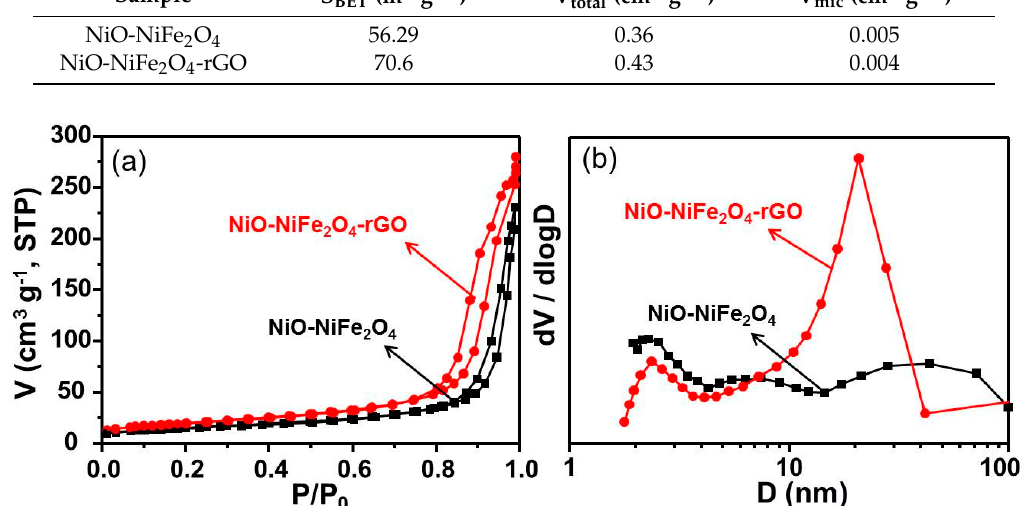
Table 1. Structural properties of NiO-NiFe 2 O 4 and NiO-NiFe 2 O 4 -rGO.